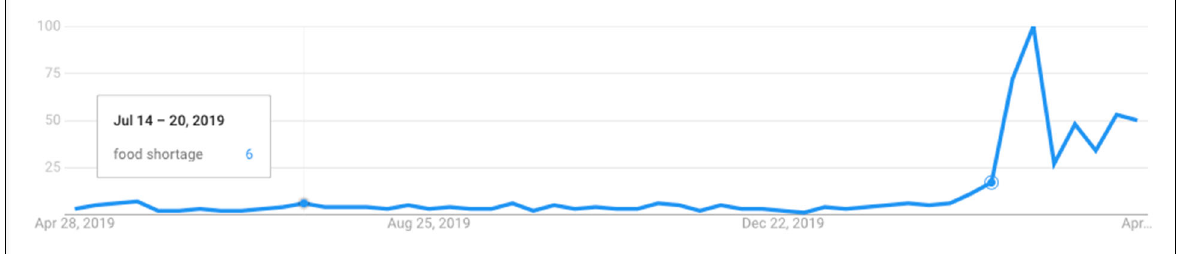
Source: Google Trends, April 27, 2020; the geography of search is the U.S.; circles to the right show week of March 1–7,